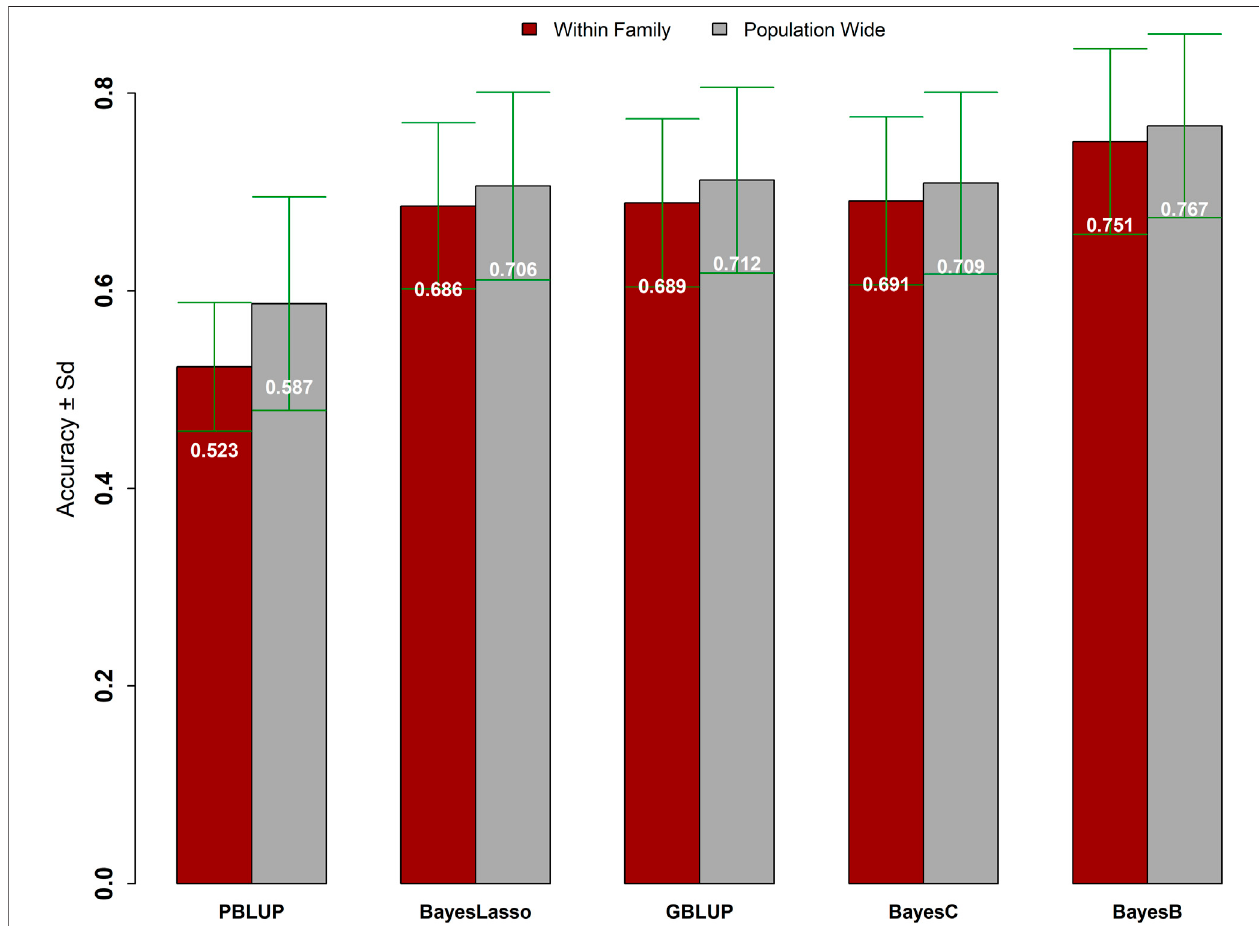
FIGURE 4 | The accuracies of prediction for resistance against VNN using pedigree vs. genomic models.